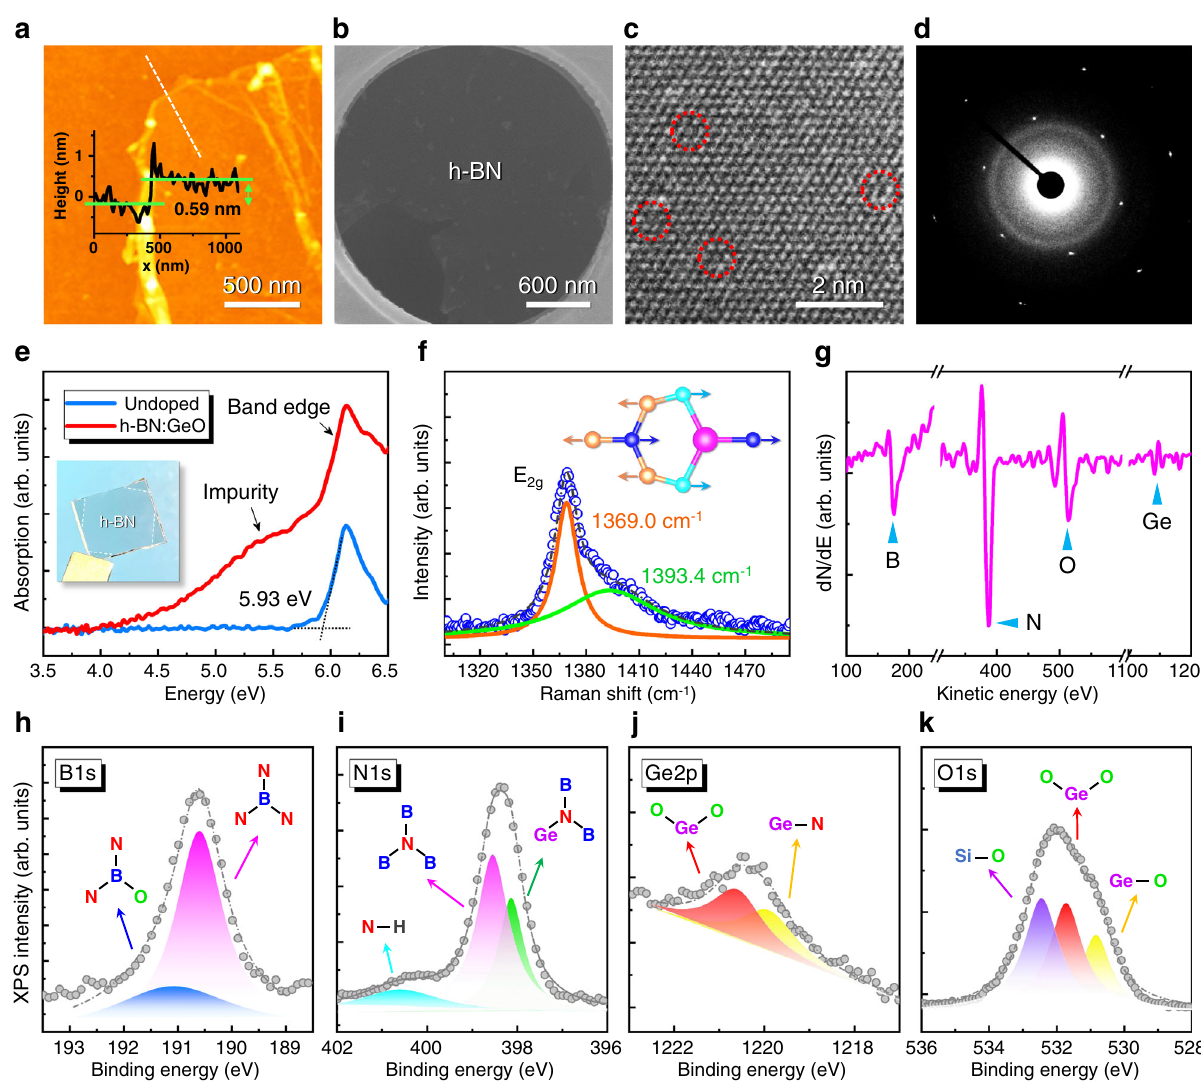
Fig. 3 Structural characterization of the h-BN:Ge-O monolayer. a AFM image of the h-BN:Ge-O fi lm on SiO 2 , showing monolayer thickness. b SEM image of the suspended h-BN:Ge-O monolayer supported on a TEM grid. c HRTEM image and ( d ) SAED pattern of the h-BN:Ge-O monolayer. e Absorption spectra of the undoped h-BN and h-BN:Ge-O. f Raman spectrum of the h-BN:Ge-O fi lm. The inset shows the corresponding E 2g vibrational mode. g AES spectrum of the h-BN:Ge-O fi lm. h – k XPS spectra of the h-BN:Ge-O fi lm, showing the B 1s , N 1s , Ge 2p , and O 1s core levels,